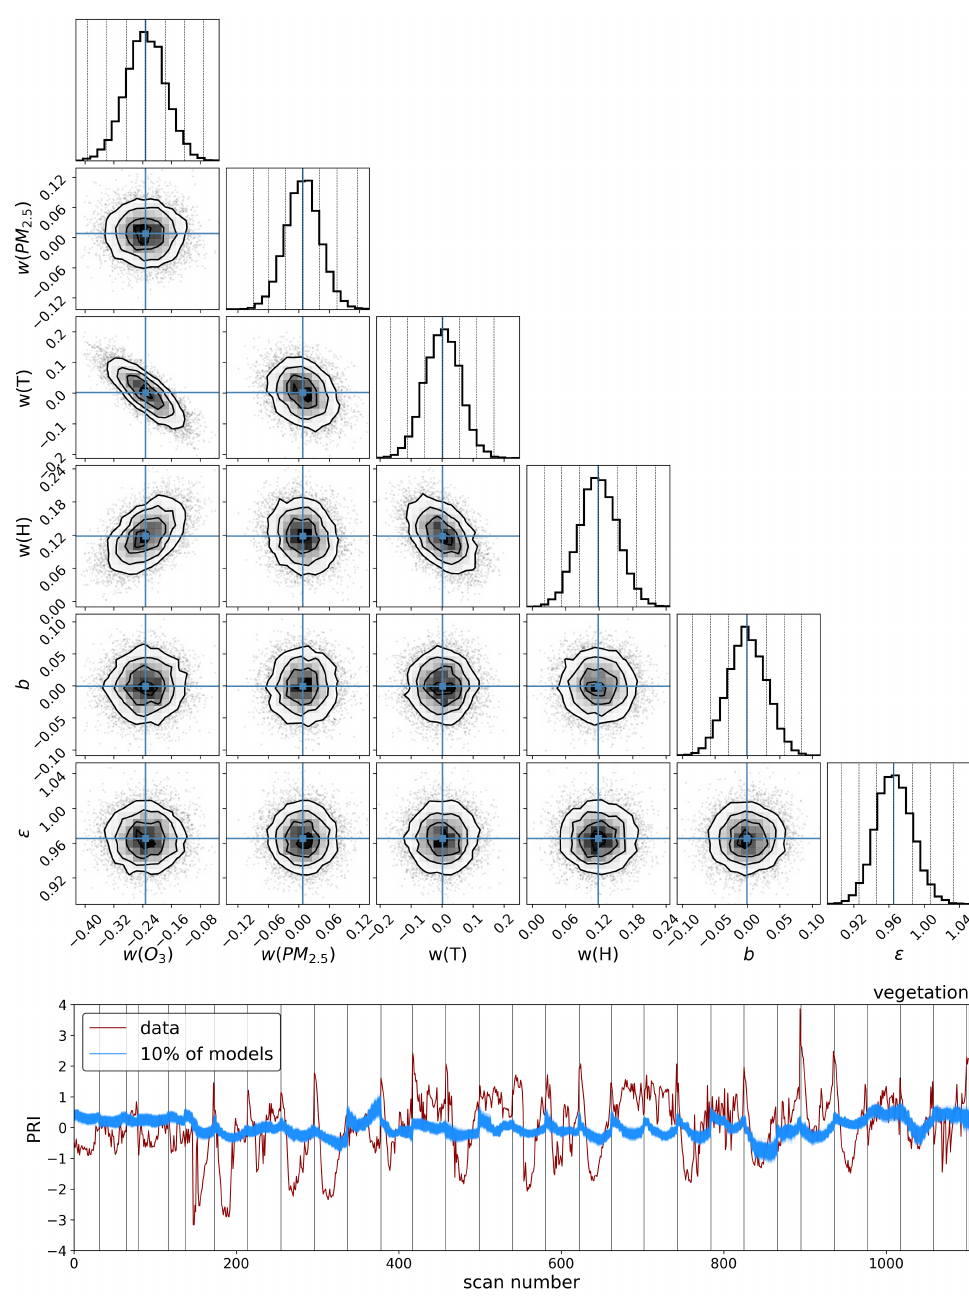
Figure A3. MCMC corner plot of posterior distribution for PRI of